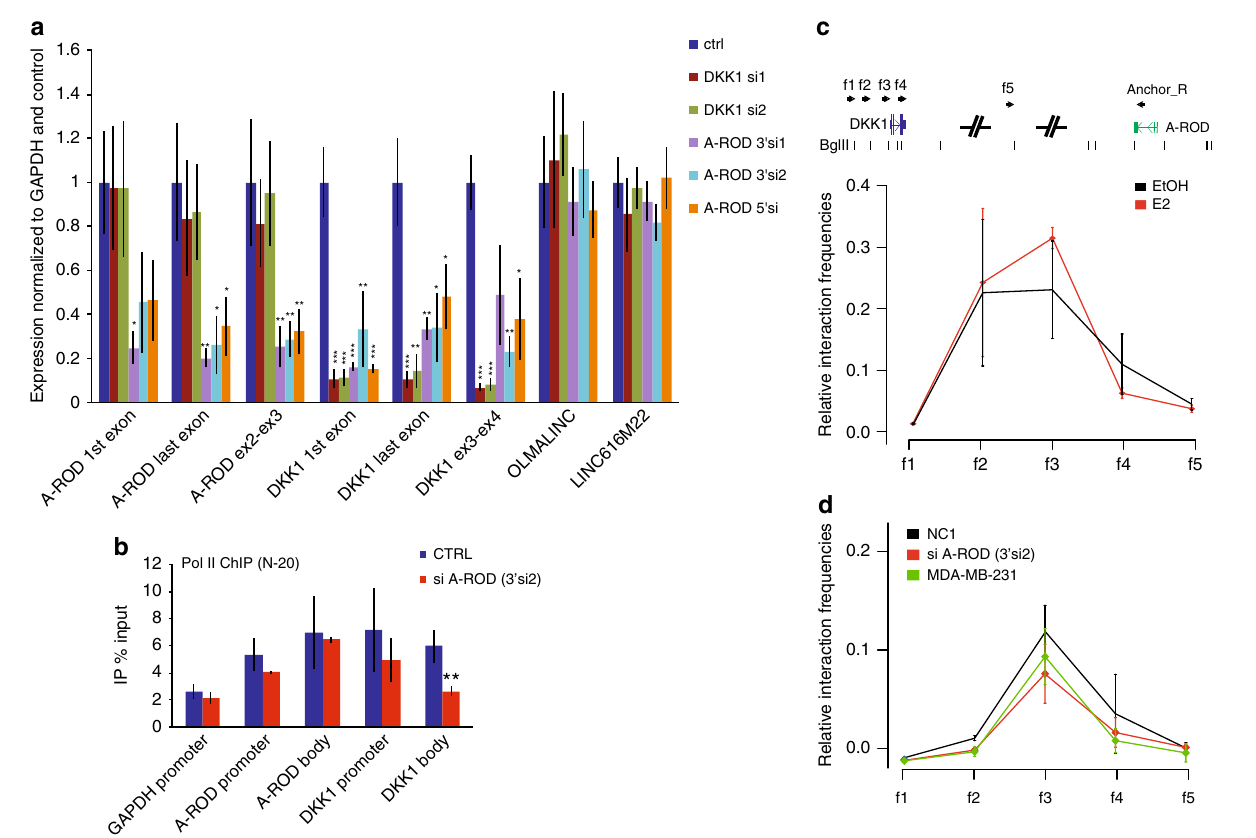
Fig. 3 A-ROD enhances DKK1 transcription. a RT-qPCR levels of A-ROD, DKK1 and two unrelated long ncRNAs, in control and various siRNA treated cells, normalized to GAPDH and control condition. Whole-cell total RNA was reverse-transcribed with random primers. Error bars represent normalized standard deviations from three independent experiments ( n = 3 biological replicates, * p < 0.05, ** p < 0.01, *** p < 0.001, two-tailed Student ’ s t -test). b ChIP assaying total Pol II occupancy in control and A-ROD siRNA (#A-ROD.3 ’ si2) treated MCF-7 cells using the N-20 antibody. Error bars represent standard deviations from three independent experiments ( n = 3 biological replicates, ** p < 0.01, two-tailed Student ’ s t -test). c , d Chromosome conformation capture of c the DKK1 A-ROD interaction in control (EtOH) and 40 min E2 induced MCF-7 cells and of d the DKK1 A-ROD interaction in control (NC1) or A-ROD siRNA transfected MCF-7 cells, and in MDA-MB-231 cells. Relative interaction frequencies derived as described in Methods